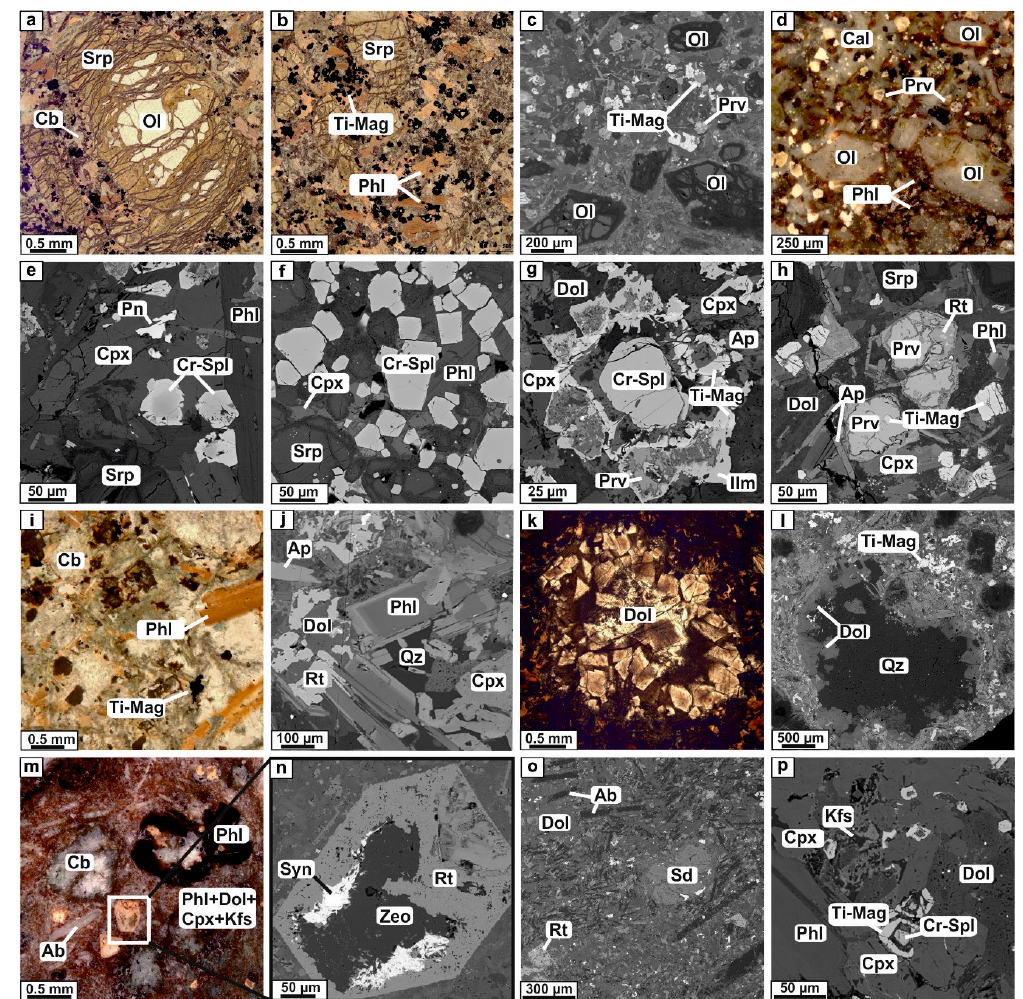
Figure 2. Photomicrographs ( a,b,d,i,k,m ) and back-scattered electron imaging (BSE) images ( c,e–h,j,l,n–p ) of mineral assemblages of the Terina complex UMLs: a–d aillikites, e–l mela-aillikites, m–p damtjernites. ( a–d ) Porphyritic structures of aillikites: olivine (Ol) (replaced by serpentine (Srp)) and phlogopite (Phl) macrocrysts are located in the groundmass presented by calcite (Cal) and phlogopite phenocrysts, with Ti-magnetite (Ti-Mag) and perovskite (Prv) mineral assemblages. ( e ) Zonal crystals of the spinel-group minerals with Cr-spinel (Cr-Spl) core and Ti–magnetite rims; the mela-aillikites ( e–l ) differ from the aillikites by the presence of xenomorphic grains of clinopyroxene (Cpx) in the groundmass; ( g,h ) perovskite crystals are replaced by ilmenite (Ilm) and rutile (Rt) with Ti-magnetite association in the carbonate (Cb) matrix; ( i,j ) mineral assembleges of the mela-aillikites; the minor and accessory minerals also include fluorapatite (Ap) and sulphides (ex. pentlandite (Pn)). ( k,l ) The secondary hydrothermal quartz-dolomitic aggregates (globules). ( m–p ) Damtjernite differs from the mela-aillikites by the presence of albite and K-feldspar in the groundmass of the ultramafic lamprophyres. ( m,n ) Perovskite is fully replaced by rutile; zeolite group minerals (Zeol) with synchysite-(Ce) (Syn) trace the hydrothermal processes as well as the formation of siderite (Sd) and rutile aggregates in the groundmass mineral assembleges ( o,p ).